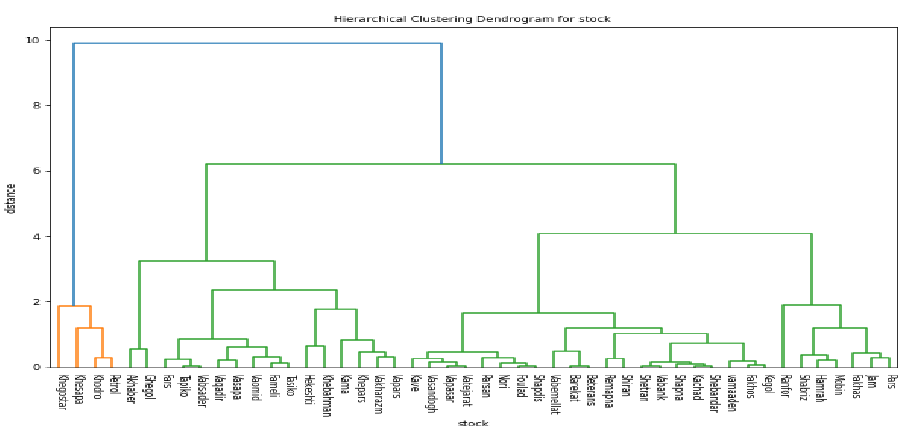
Figure 6. Hierarchical Clustering, a dendrogram of stock Clustering based on Euclidean